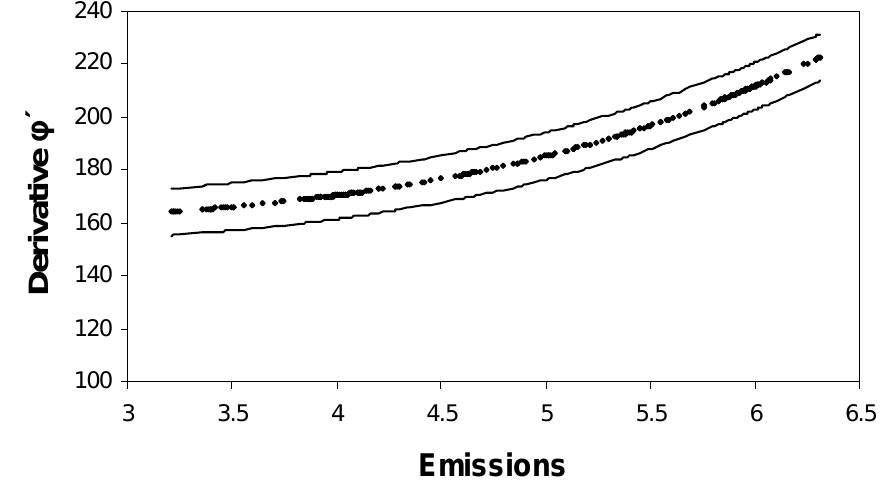
Figure 3. Marginal effect of emissions. Figure 3: Marginal E⁄ect of Emissions Table 1. Output elasticity of emissions. C ONTRIBUTION TO TFP G